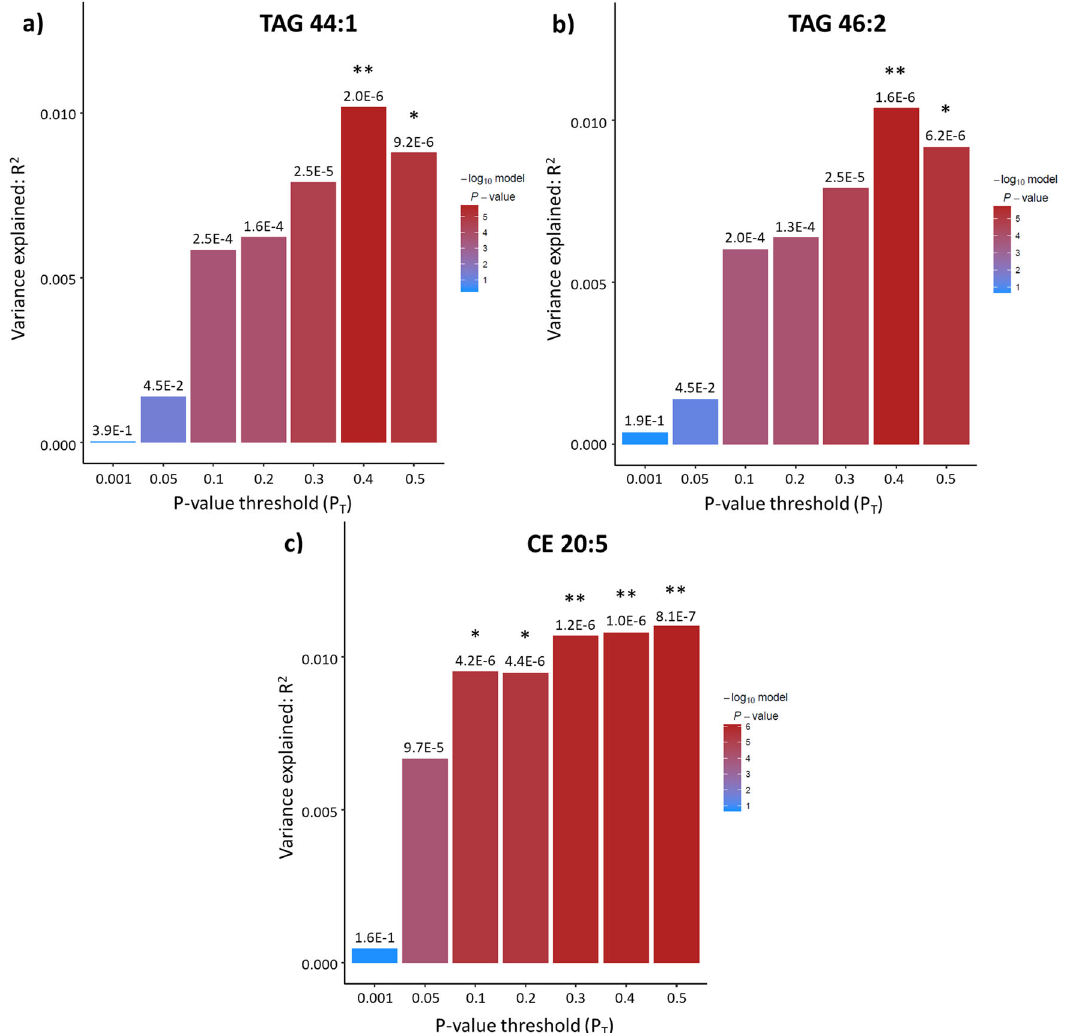
Fig. 2 Shared genetic etiology between Parkinson ’ s disease (PD) and blood levels of TAG 44:1, TAG 46:2, and CE 20:5. Bar plots for shared genetic etiology between PD and the blood levels of triacylglycerol (TAG) 44:1 ( a ), triacylglycerol (TAG) 46:2 ( b ), and cholesterol ester (CE) 20:5 ( c ) showing the variance explained ( R 2 ) and the SNP P value threshold ( P T ). The asterisks above the bars indicate the Bonferroni-corrected signi fi cance of the genetic overlap between PD and the blood lipid levels; * denotes P < 0.05/2590 tests (7 thresholds × 370 blood lipid levels) = 1.93E-05, ** denotes P < 0.01/2590 = 3.86E-06; *** denotes P < 0.001/2950 =